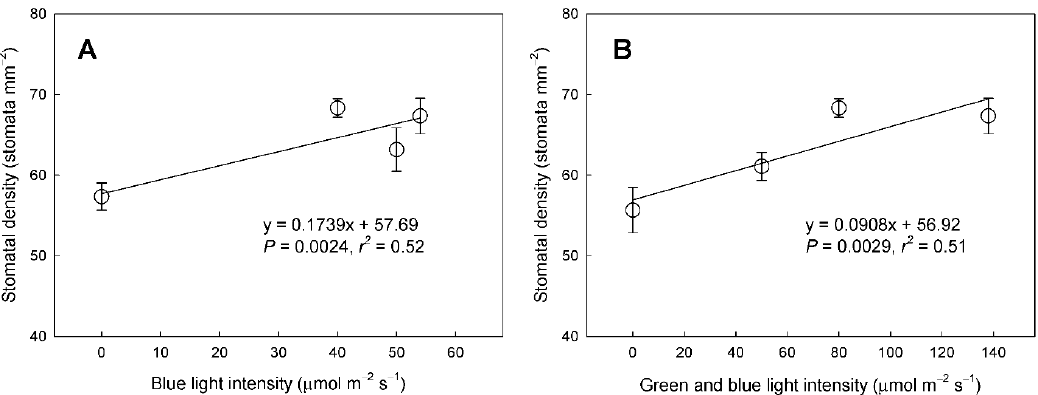
Figure 8. Correlations of the stomatal density of Ocimum basilicum with irradiated ( A ) blue light intensity and ( B ) green and blue light intensity. Plants were grown under five different combinations of red, green, and blue LEDs with the same light intensity for 14 days. Values are the means of three or six replicates. Error bars indicate the standard error.